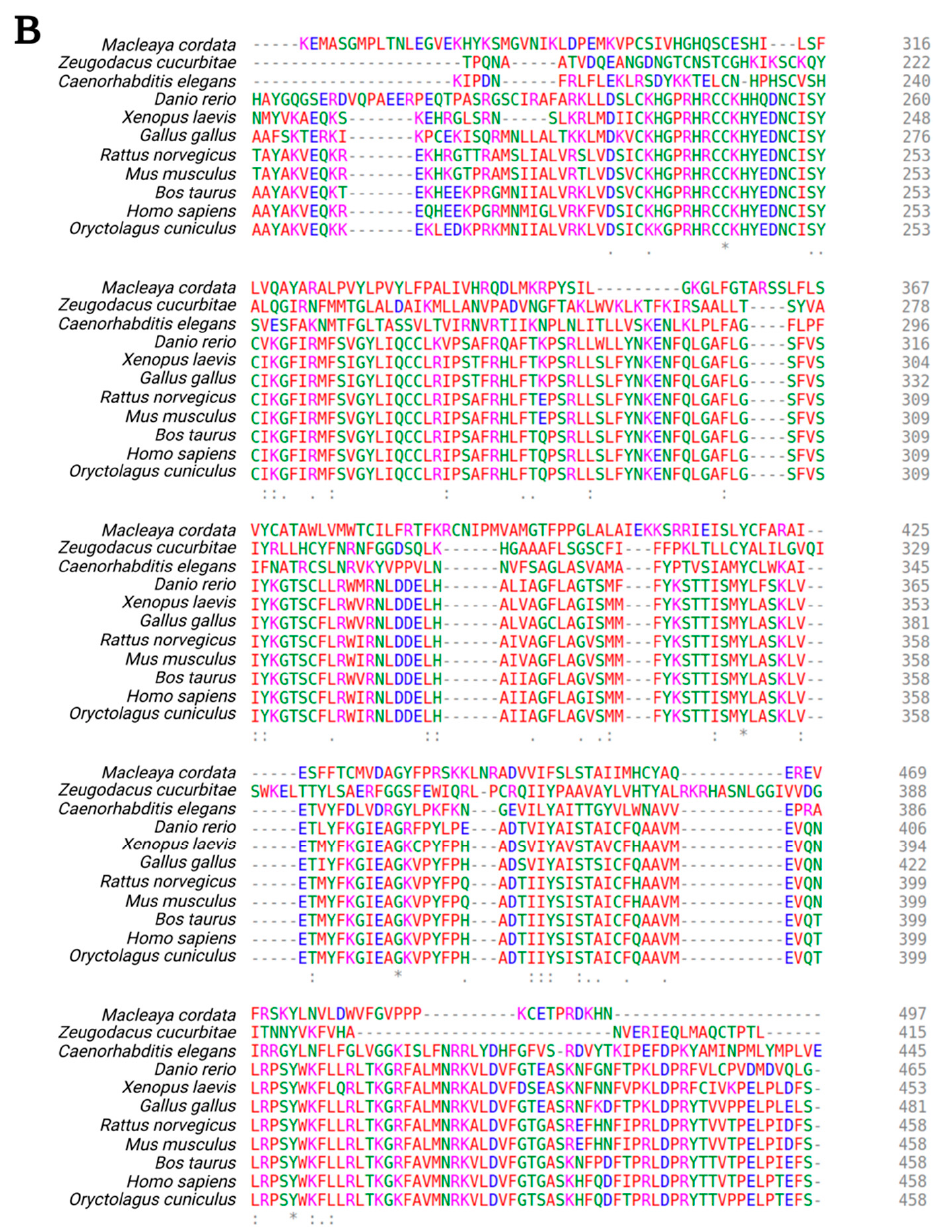
Figure 1. Comparison of the sequence homology of TMEM135 ( A , B ) across 11 different species using Clustal Omega Multiple Sequence alignment software (v.1.2.4). Clustal Omega designates the following colors for amino acid groups: AVFPMILW-Red: Small (small + hydrophobic [includes aromatic –Y])DE-Blue: Acidic, RHK-Magenta: Basic -H,STYHCNGQ -Green: Hydroxly + sulfhydryl + amine + G Others-Gray: Unusual amino/imino acids etc. (Accession numbers for TMEM135 species: OUZ99344.1, JAD00441.1, NP_508800.2, NP_001082887.1, NP_001085541.1,